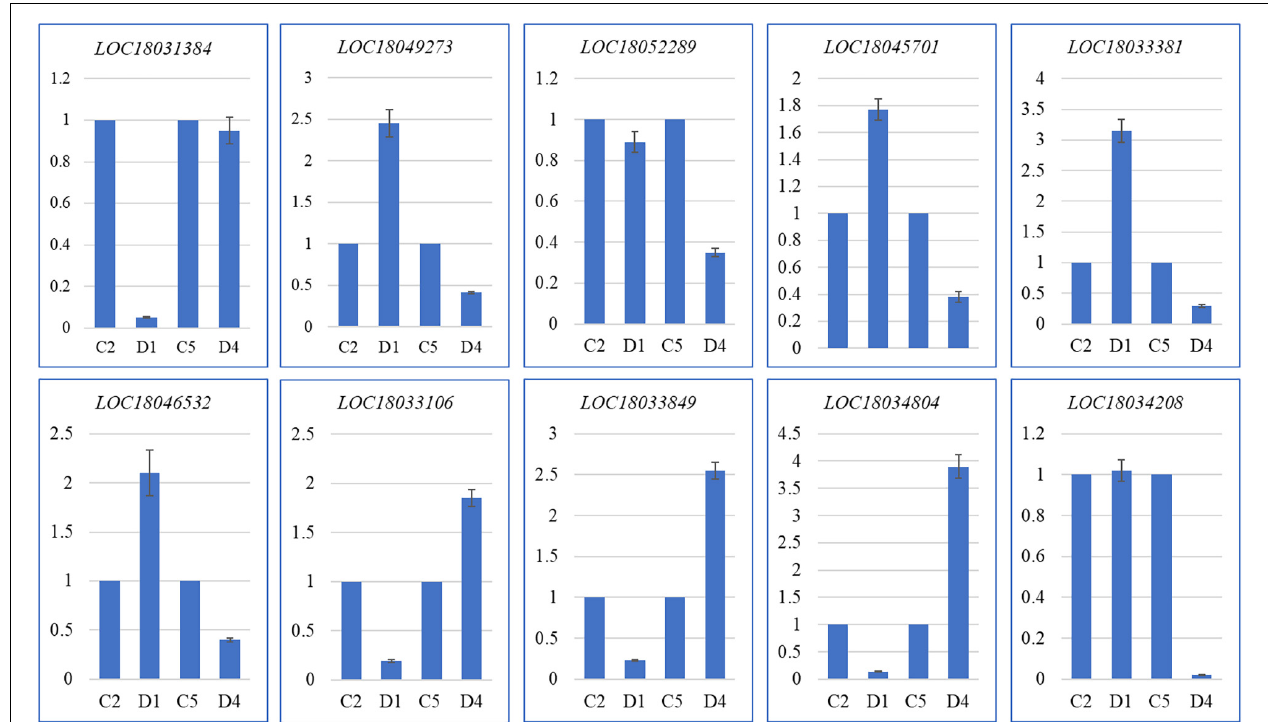
FIGURE 4 | Quantitative real-time (qRT)-PCR analysis of selected DEGs in C and D of C. limon. D1 and C2, and D4 and C5 represent the samples collected 60 and 150 days after flowering, respectively. The Y -axis represents relative gene expression (mean of three replicates) and the X -axis represents C. limon peels harvested at different days after flowering. The error bars represent